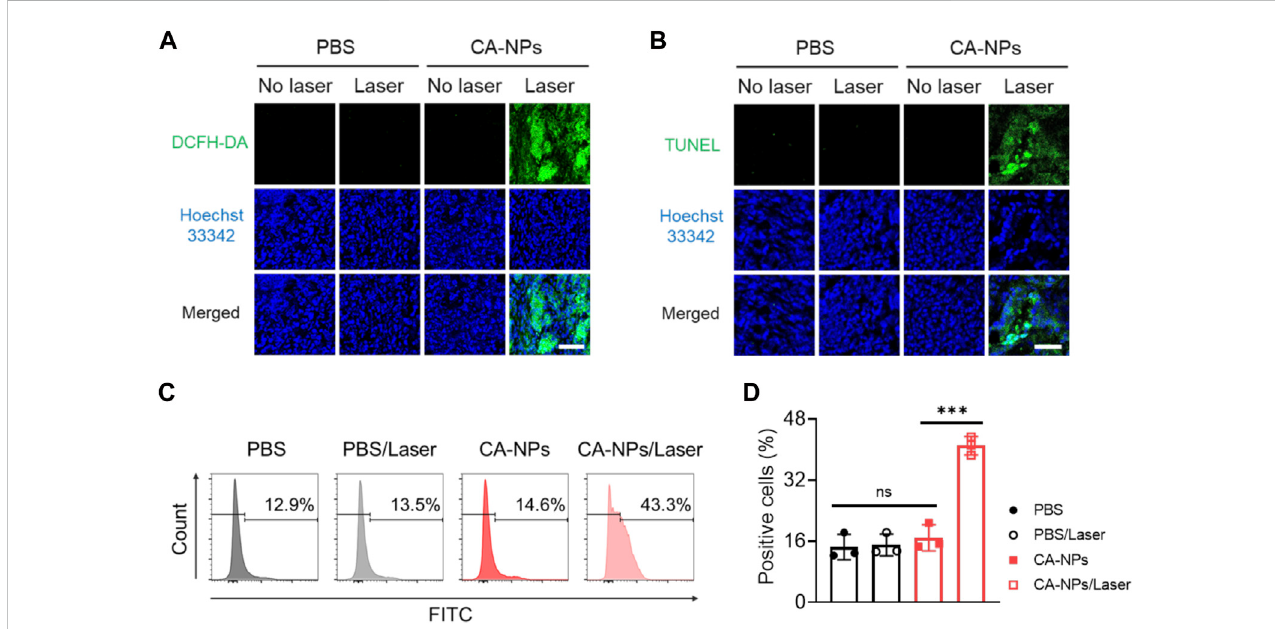
FIGURE 6 Anti-tumoreffectofCA-NPsagainstbladdertumorsectionsfrompatients. (A) DCFH-DAstainingofhumanbladdertumortreatedwithPBSandCA-NPs under irradiation or not (0.15 W/cm 2 , 5min) post intratumoral injection of 1 μ g Ce6. Scale bar: 100 μ m. (B) TUNEL staining of human bladder tumor treated with PBS and CA-NPs under irradiation or not. Scale bar: 50 μ m. (C,D) . Flow cytometric measurement of positive cells of TUNEL staining in human bladder tumor treated with PBS and CA-NPs under irradiation or not. (n = 3; ns: no signi fi cance, ** p < 0.01, *** p <